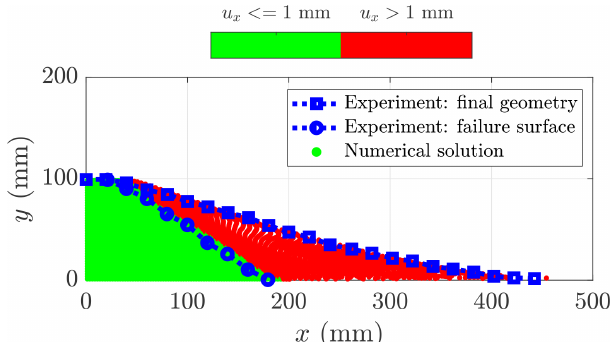
Figure 18. Number of floating point operations per second (flops) with respect to the total number of material points n p for the vector- ized implementation. The discontinuous lines refer to the functions of the solver, and the continuous line refer to the solver. A peak performance of 900 Mflops is reached by the solver for n p > 1000, and a residual performance of 600 Mflops is further resolved for an increasing n p .